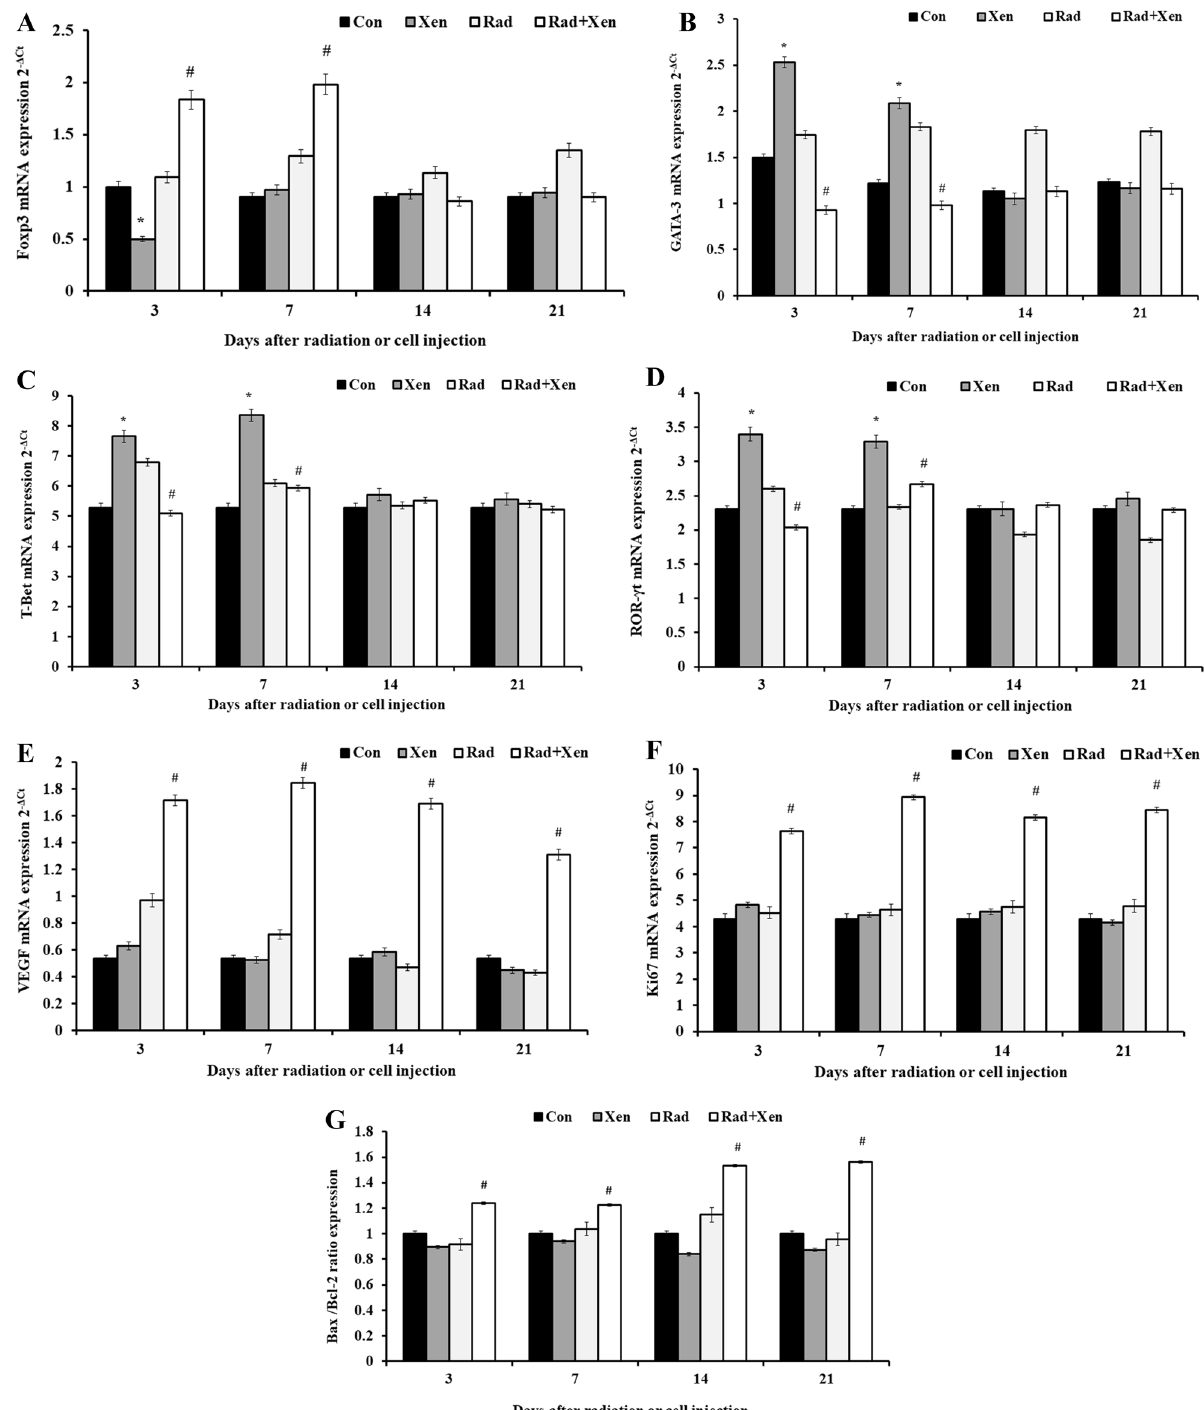
Figure 4. The spleen expression of Foxp3 (A), GATA-3 (B), T-Bet (C), and ROR-γt (D), VEGF (E), Ki67 (F), and Bax/Bcl-2 ratio (G) on days 1, 3, 7, and 14 after gamma radiation in BALB/c mice. Con: control, Xen: cell injection group, Rad: gamma radiation group, and Xen + Rad: gamma radiation plus cell injection group. Data were reported as mean ± SD. *P ≤ 0.05 compared to the control group, # P ≤ 0.05 compared to the Xen